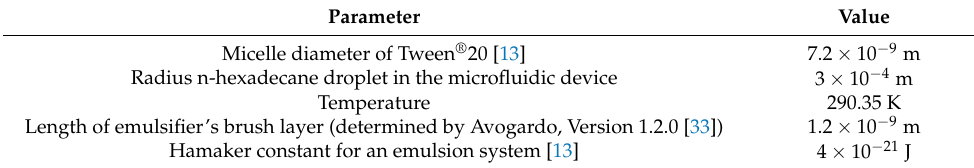
mined by Avogardo, Version 1.2.0 [33])